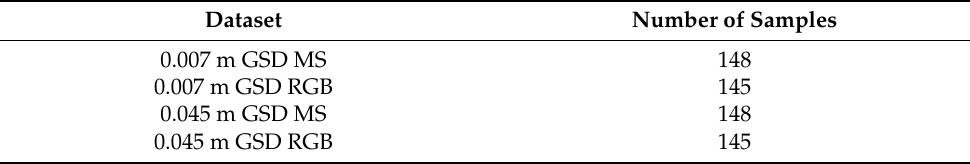
Table 2. Number of samples in each dataset.